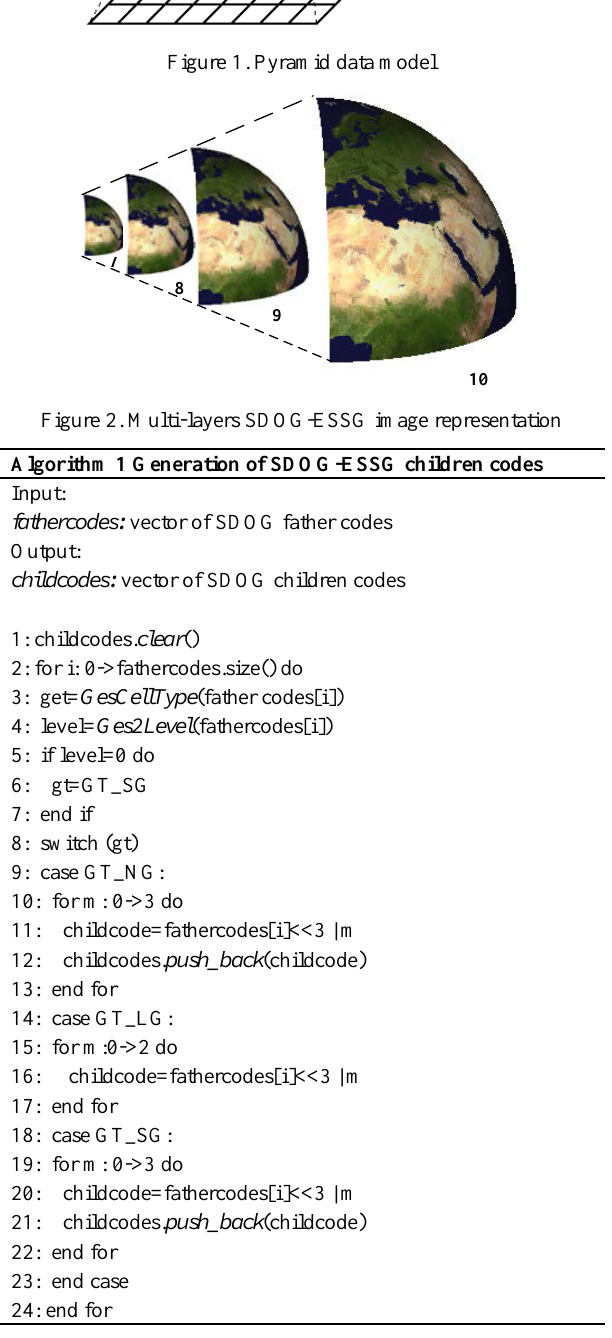
Figure 1. Pyramid data model